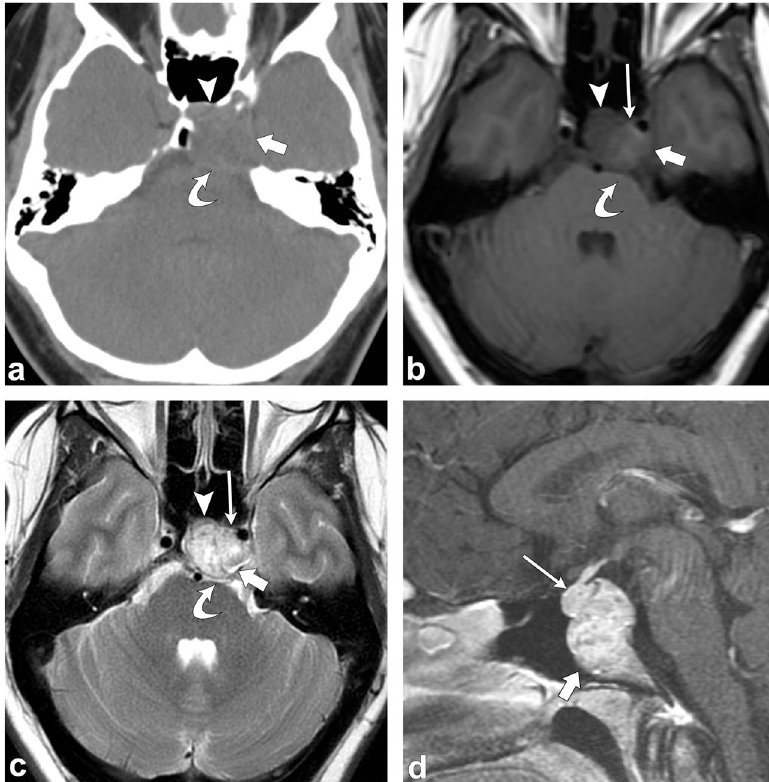
Fig. 19 Chordoma. Axial head CT ( a ) shows an osteolytic destructive lesion involving the clivus ( thick arrows ) with extension into the posterior sphenoid sinus (arrowhead) and impression on the pons ( curved arrow ). Axial T1-weighted ( b ), axial T2-weighted ( c ) and sagittal post-contrast T1-weighted ( d ) images demonstrate an expansile mass centred at the clivus extending into the sphenoid sinus ( arrowhead ), left cavernous region ( short, thick arrows ) and partially encasing the left internal carotid artery. This mass enhances and displaces the pituitary gland ( thin, long arrow ) and has mass effect on the left aspect of the pons ( curved arrow